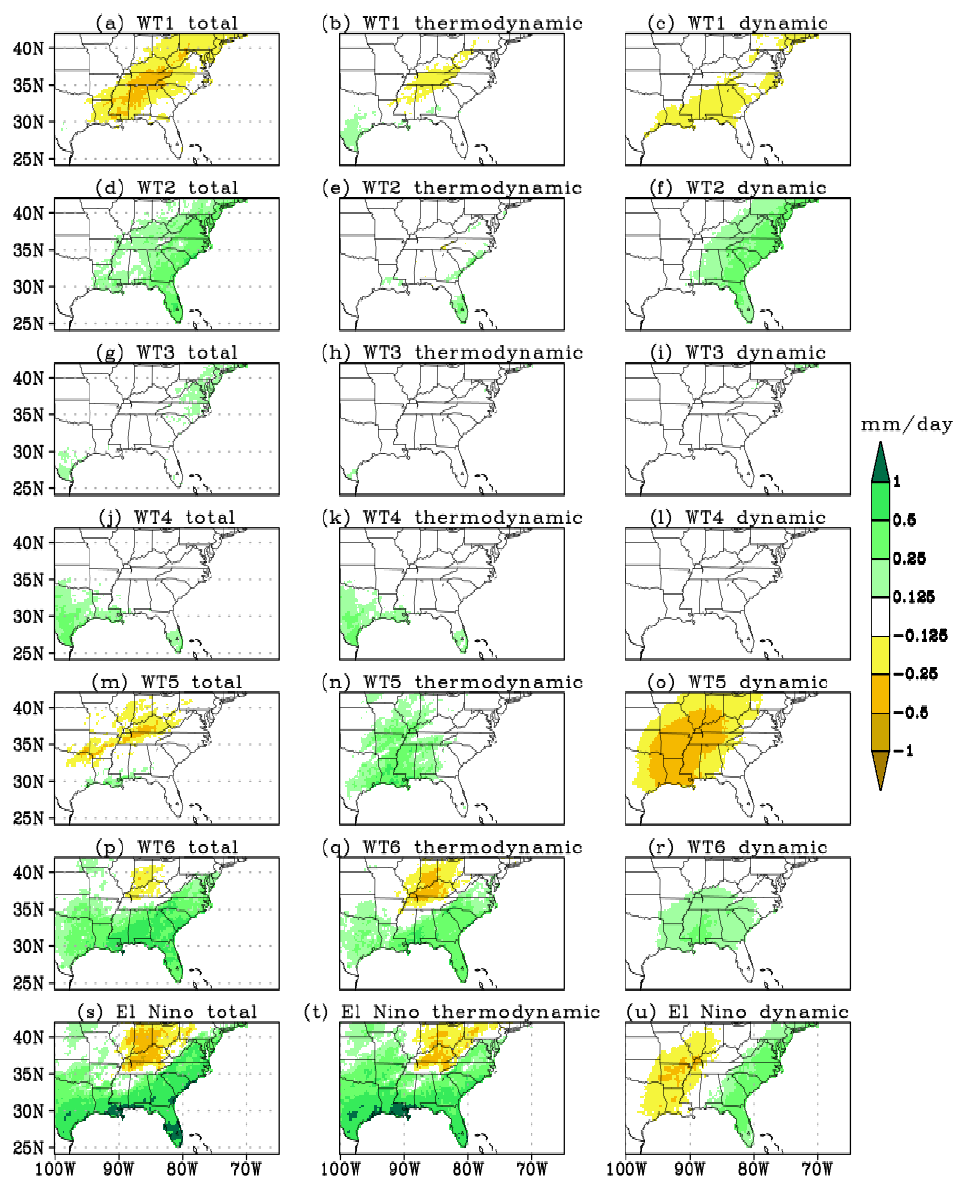
Figure 8. Precipitation anomalies in El Niño years in December – February (panel ( s )). Panels ( a – r ) are the contribution of the WTs 1 – 6 to the anomalous precipitation. Left, middle and right panels are the total, thermodynamic and dynamic contribution from each WT, respectively. Panels ( t , u ) are the sum of thermodynamic and dynamic contribution for all WTs, respectively.